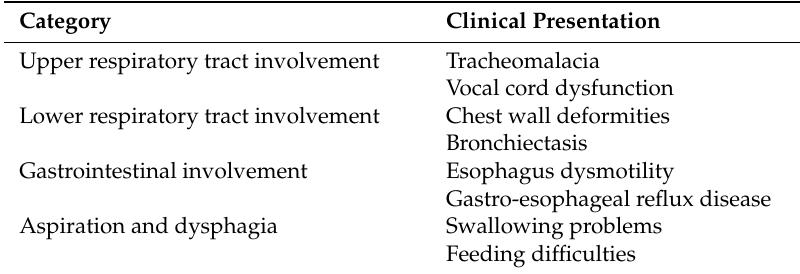
Table 2. Long-term respiratory morbidity in patients with repaired congenital esophageal atresia and tracheoesophageal